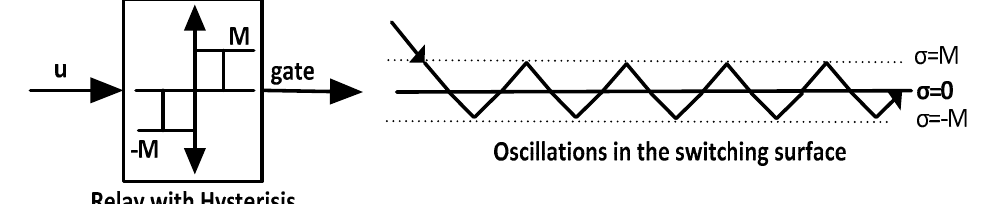
Figure 7. Dynamic relay with hysteresis function.